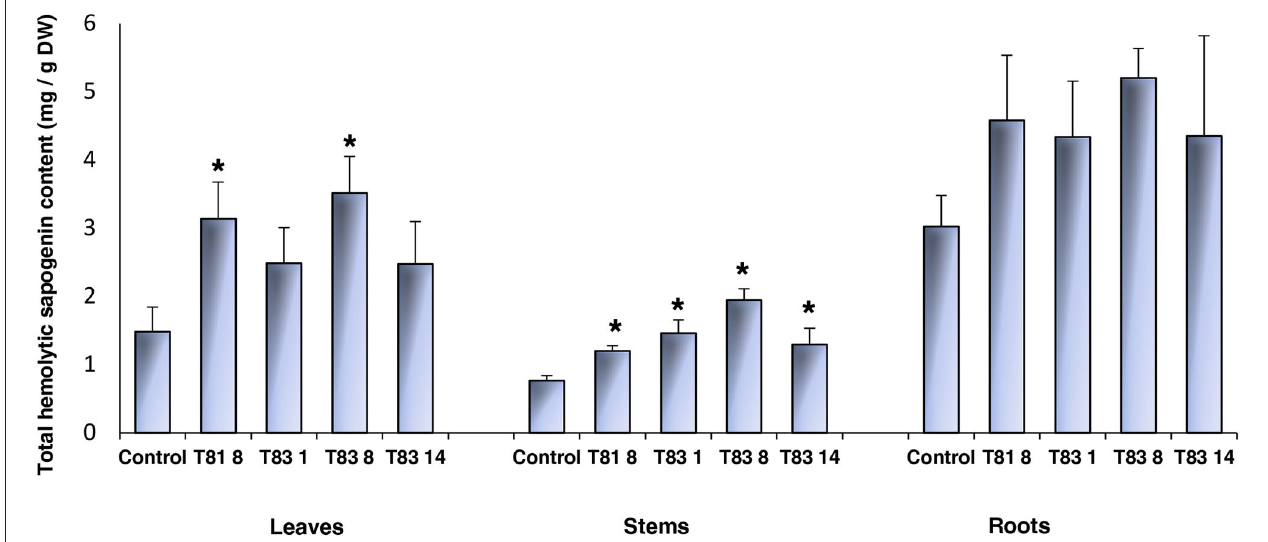
FIGURE 4 | Total hemolytic sapogenin content in leaves, stem and roots of control and CYP93E2 mutant barrel medic plants under greenhouse experimental conditions. Data are shown as the mean values of four biological replications of single-plant experimental units with error bars representing standard deviation. An asterisk indicates means significantly different from control according to Dunnett’s Test ( p < 0.05).